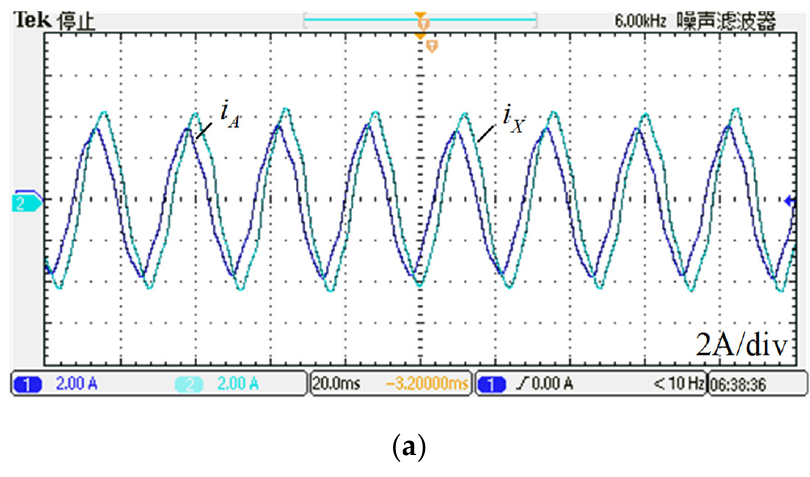
Phase A Phase X Figure 7.